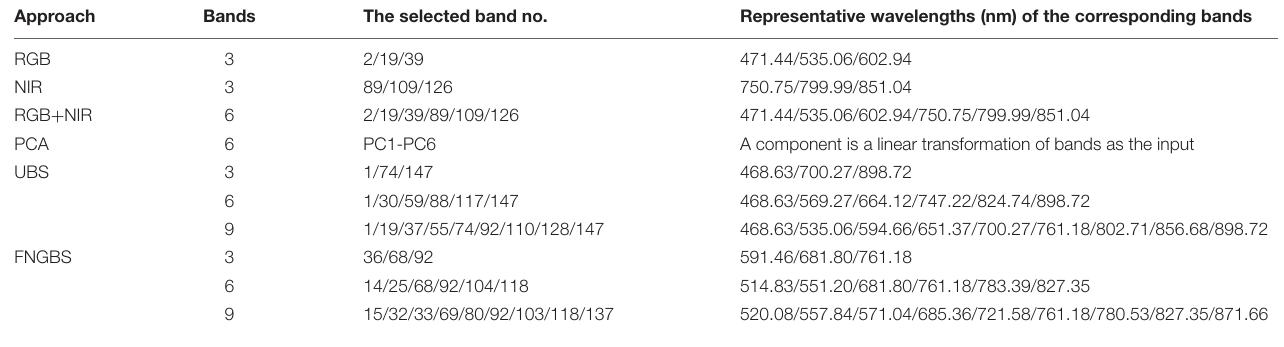
TABLE 4 | The selected bands and corresponding wavelengths of the hypercube image for species